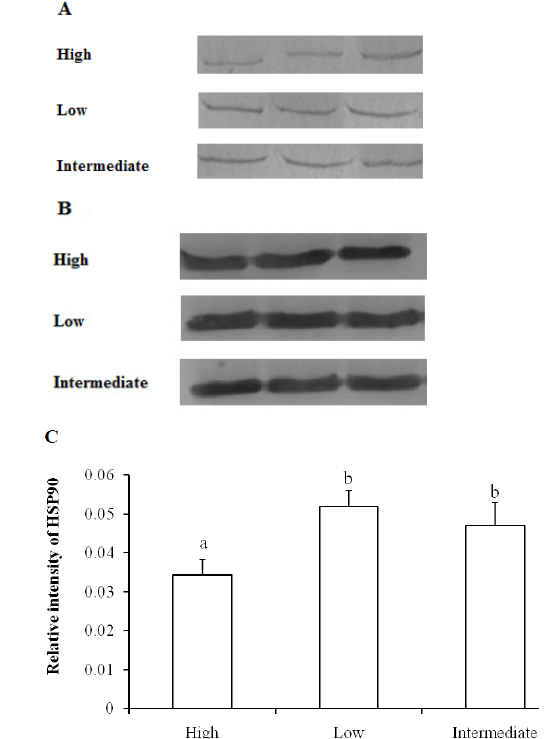
Figure 1. Western blot of heat shock protein (HSP) 90 (A), glyceraldehyde-3- phosphate dehydrogenase (B) in high (n = 6), intermediate (n = 6) and low (n = 6) drip loss grouped chicken muscles, and relative intensities of HSP90 (C). Error bars are standard error of the mean. Different letters indicate significant difference at